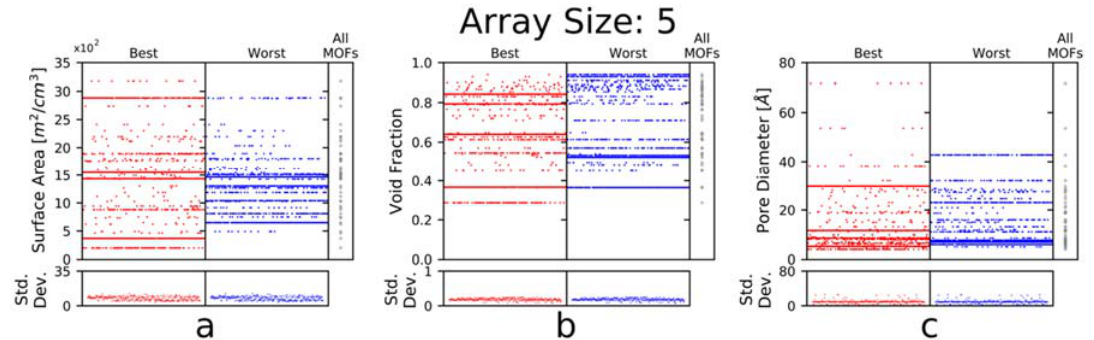
Figure 5. Physical property vs. rank (top / bottom 300 arrays), where ( a ) examines the surface area, ( b ) examines the void fraction, and ( c ) examines the pore diameter. The bottom portion of each plot shows the standard deviation of the corresponding physical property for each array (e.g., one array with the following five void fractions [0.79, 0.84, 0.54, 0.37, 0.64] would have a standard deviation in its void fraction of 0.17). The appearance of horizontal ‘lines’ corresponds to MOFs that are frequently featured in the best / worst arrays and gives us insight into both the (un)desirable properties as well as the (un)desirable spread of those